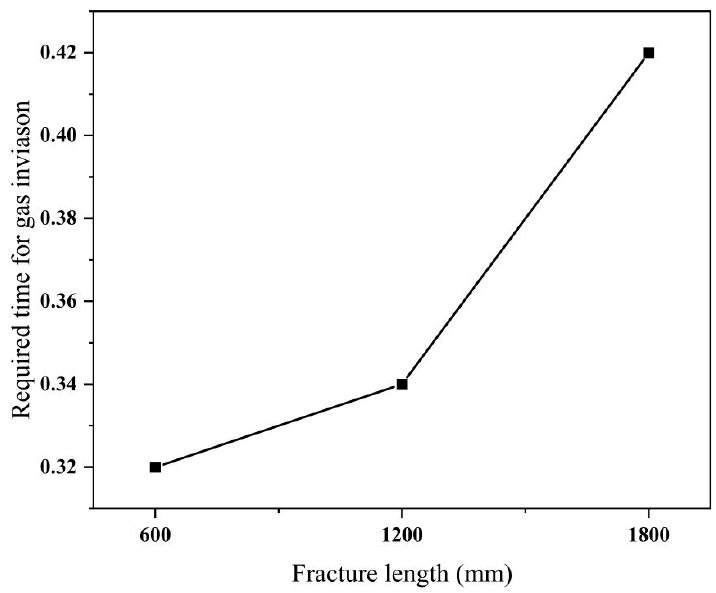
Processes 2022 , 10 , x FOR PEER REVIEW Figure 17. Time required for gas invasion under different fracture lengths. Figure 17. Time required for gas invasion under different fracture lengths.